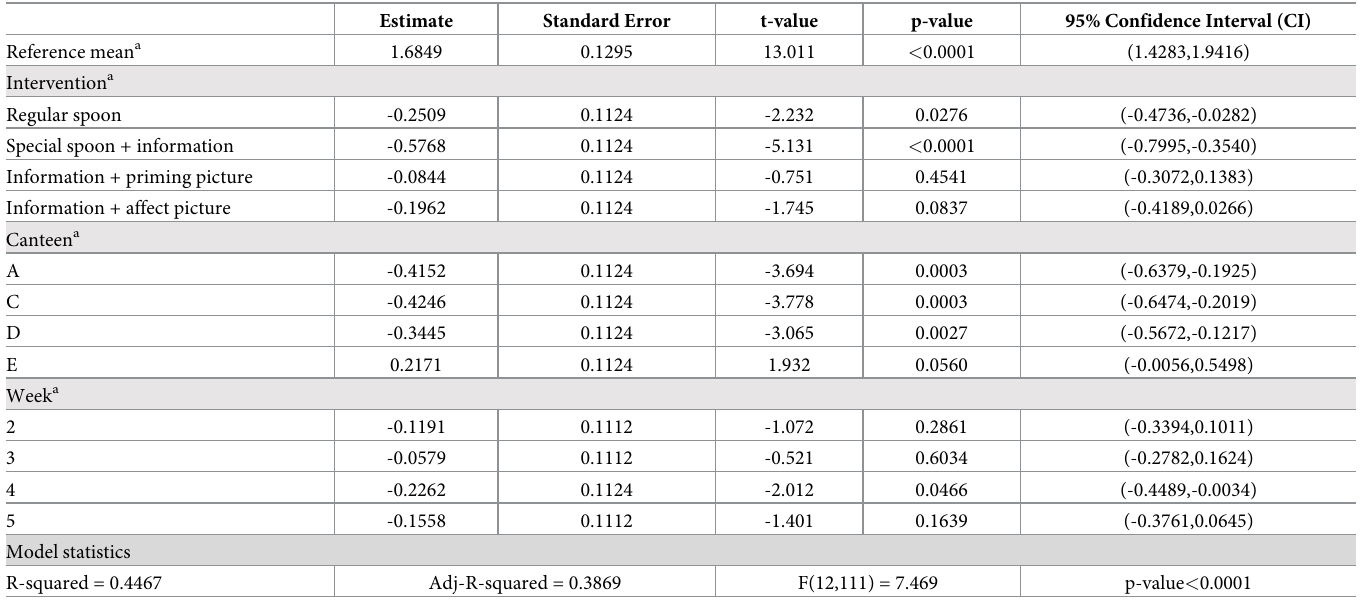
Table 3. Model results for the outcome measurement: Amount of fish sauce used (grams) per bowl sold per day.